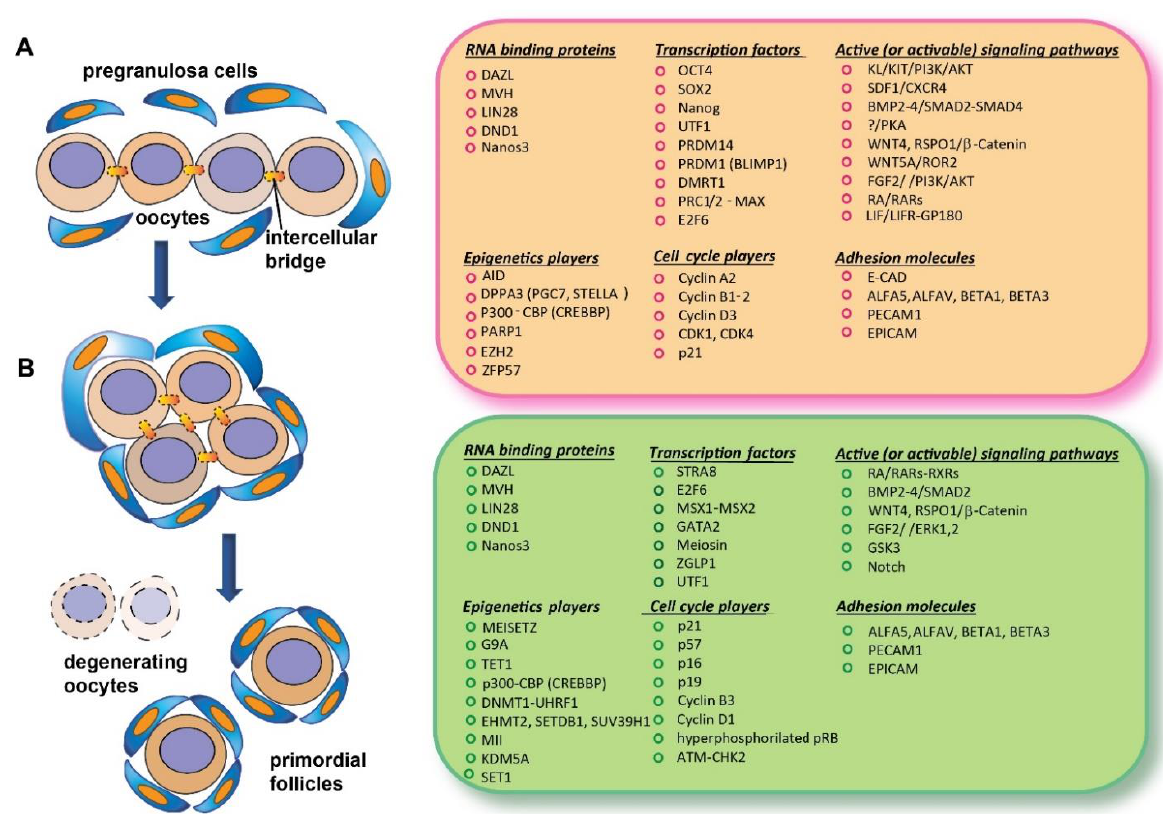
Figure 1. Schematic representation of an oogonium nest before entering meiosis ( A ) and of oocytes at the beginning of meiosis associated with nest breakdown and the formation of primordial follicles ( B ); on the right, the main classes of molecules identified in mouse oocytes during these developmental stages, with most of them being discussed in the present review.